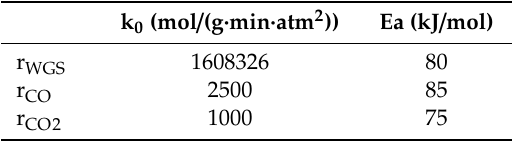
Table 4. Kinetic parameters for the structured catalyst.